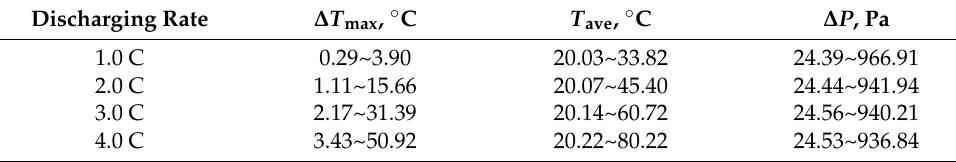
Table 8. The variation range of objectives based on Pareto optimal solution. Discharging Rate ∆ T max , ◦ C T ave , ◦ C ∆ P ,